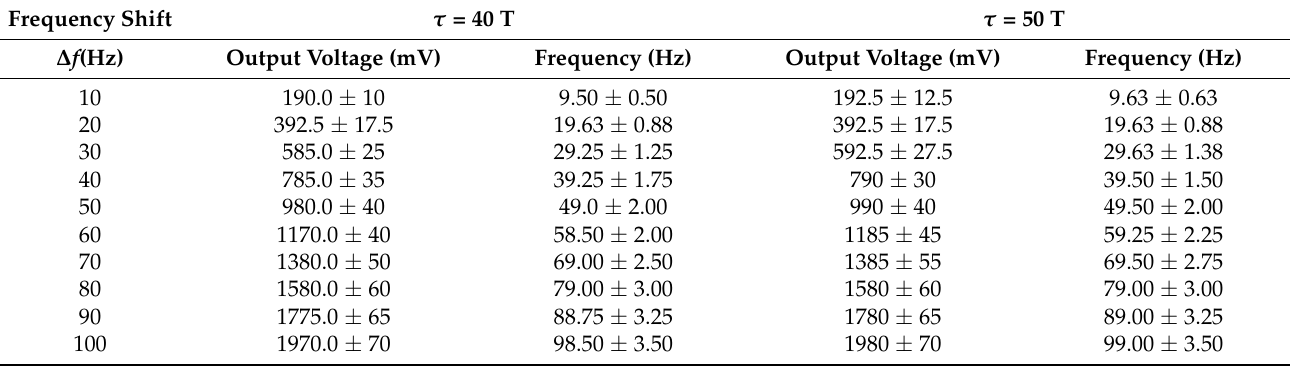
Table 2. Relative error of frequency measurement in different time